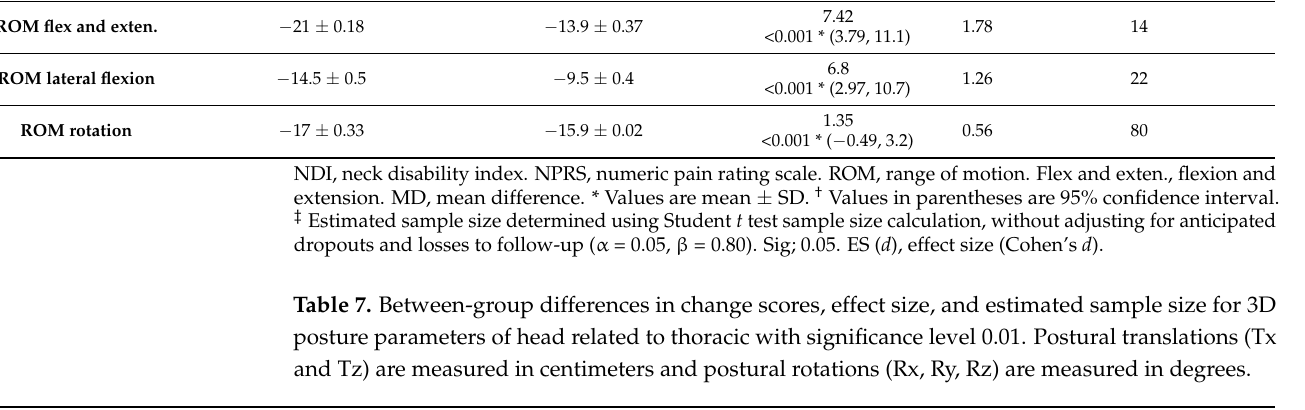
Estimated Total Sample Size for Outcome Measure, n ‡